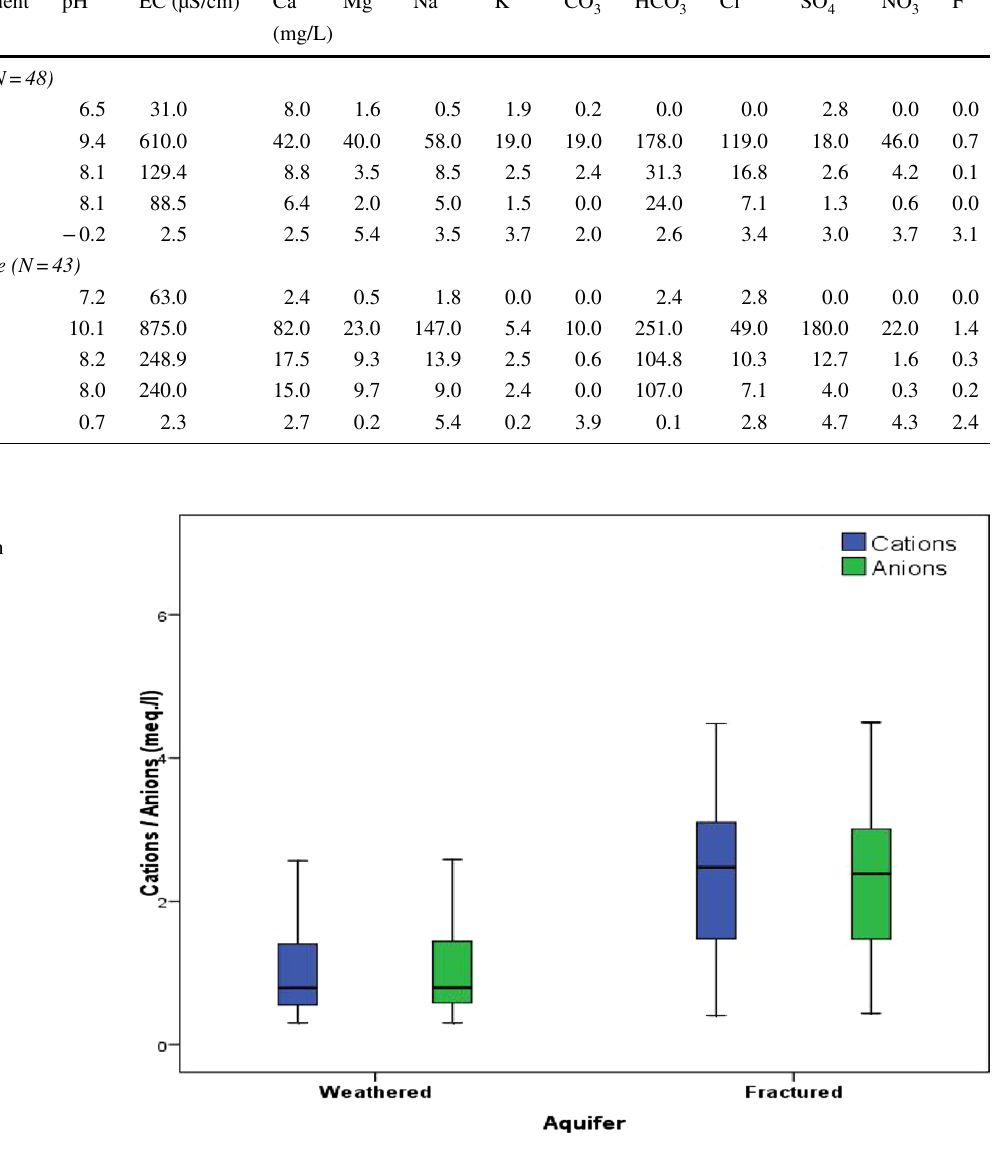
Table 2 Statistics of chemical parameters/constituents of groundwater in charnockites of Kerala Sl. no. Parameter/constituent